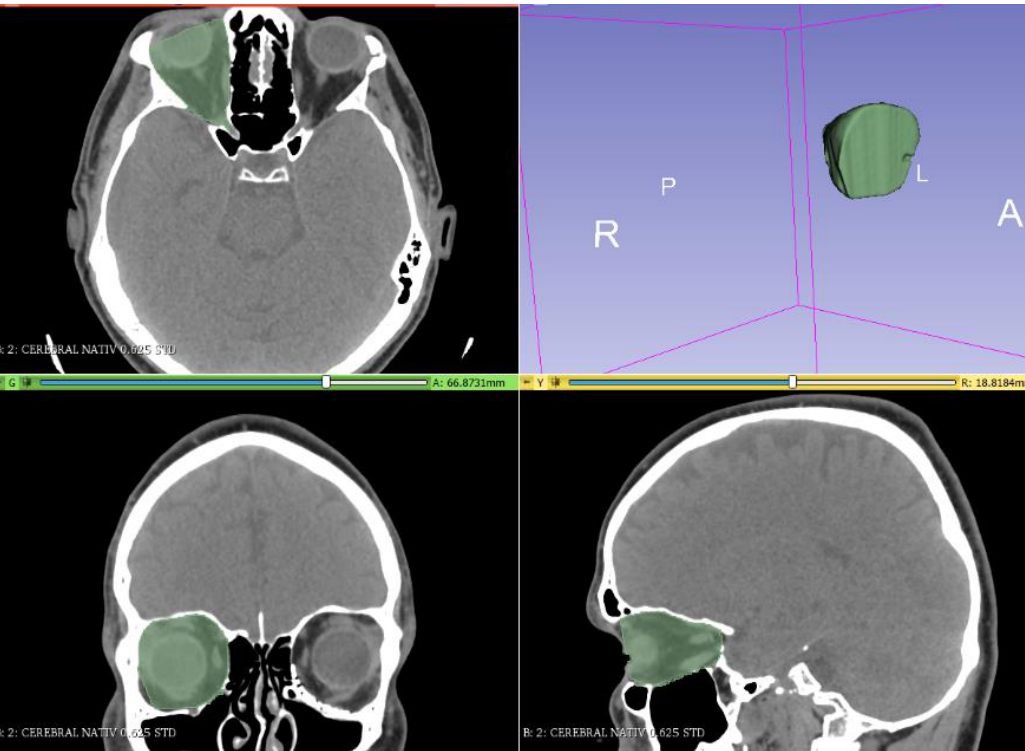
Figure 1. Segmentation of the volume of bony orbit.